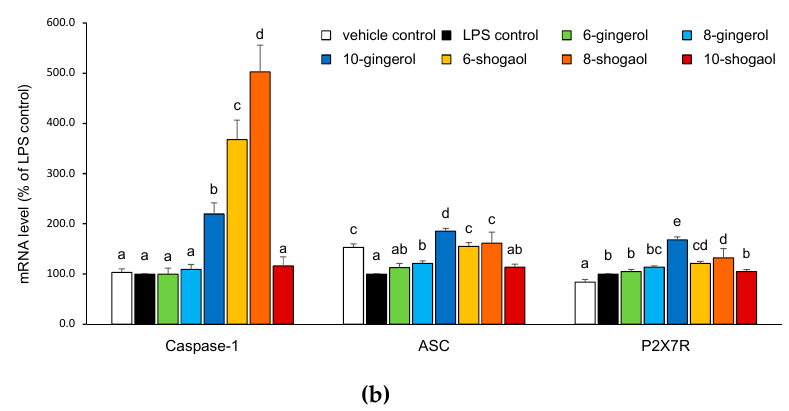
Figure 4. Effect of ginger phytochemicals on the mRNA expression of TNF- α ( a ), pro-IL-1 β ( a ), NLRP3 ( a ), caspase-1 ( b ), ASC ( b ) and P2X7R ( b ) in LPS-primed THP-1 macrophages. The PMA-differentiated THP-1 macrophages were treated with ginger phytochemicals (20 μ M) for 1h and primed with LPS for 3 h. Total cellular RNA was subjected to determine mRNA levels of target genes by quantitative PCR. Data are expressed as the mean ± SD of triplicate independent experiments. Values with different superscript letters are significant different from one another ( p < 0.05).